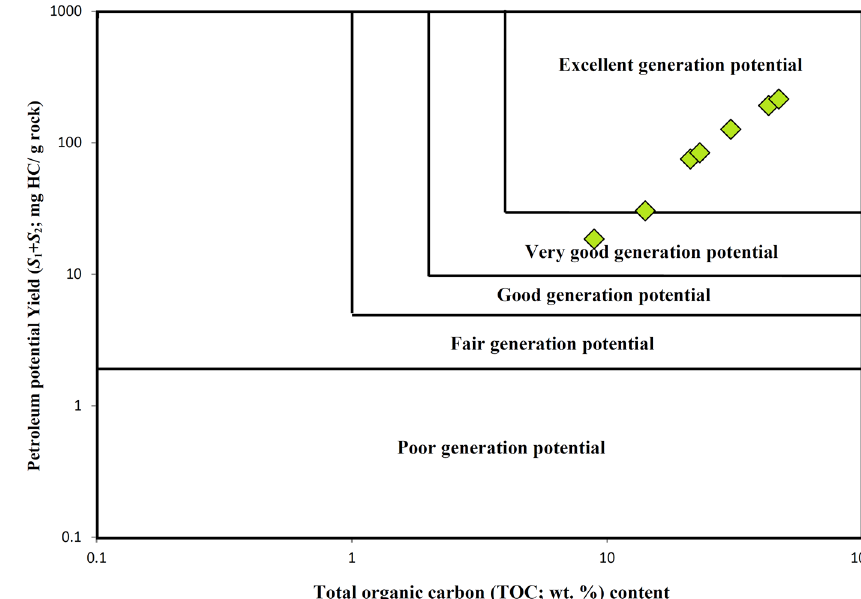
Fig. 9 Geochemical correlations between TOC content and PY ( S 1 + S 2 ) parameter, implying that the analyzed bituminite shales from Kapurdi mine location in the northern Barmer Basin are considered to be very good to excellent source rock and can generate significant amounts of petroleum during the thermal